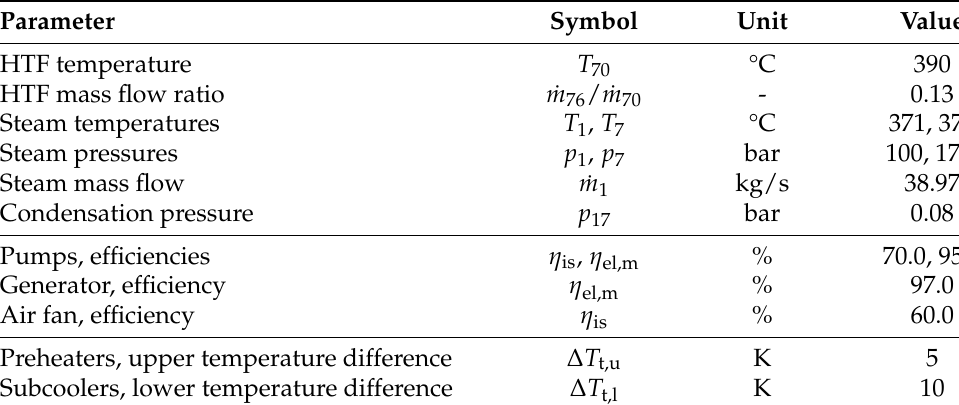
Table 2. SEGS—Parameters of the overall process and components